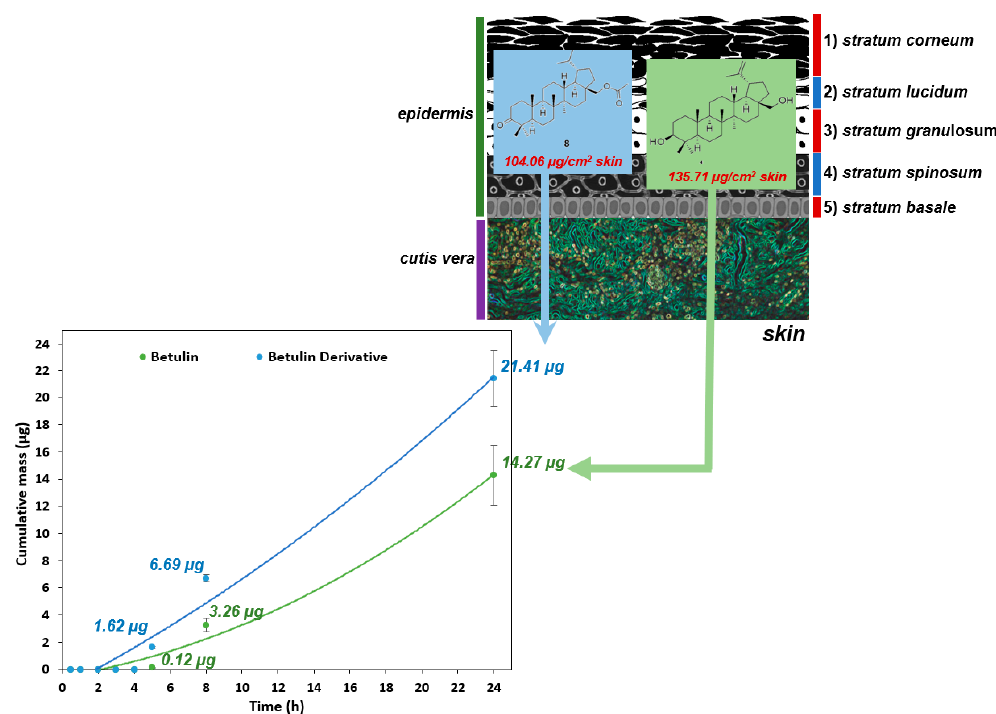
Figure 4. The cumulative mass of betulin and derivative 8 penetrated into the acceptor fluid during the 24 h experiment.